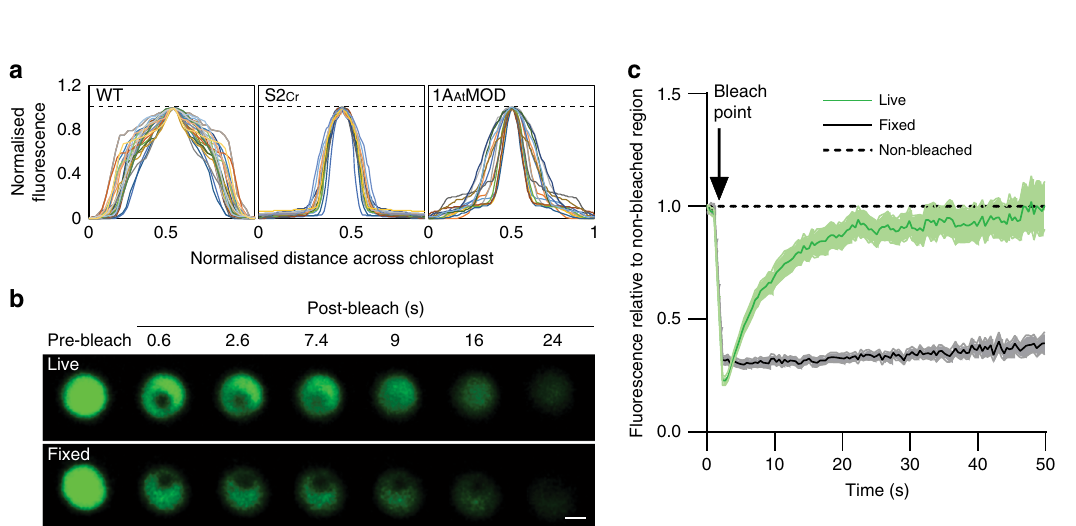
Fig. 1 Expression of EPYC1 in the Arabidopsis line S2 Cr results in condensate formation. a Schematic representation of the dual GFP expression system (EPYC1-dGFP) for EPYC1 truncated at amino acid residue 27 (as indicated by yellow triangles) and fused at the N-terminus to the chloroplastic transit peptide (TP) sequence of the Arabidopsis Rubisco small subunit RbcS1A. EPYC1 was further fused at the C-terminus to either enhanced GFP (eGFP) or turboGFP (tGFP), and driven by the 35S CaMV promoter (35S prom) or CsVMV promoter (CsVMV prom), respectively. For the latter expression cassette, a dual terminator system was used to increase expression 53 (Supplementary Fig. 1). b EPYC1 protein levels in Arabidopsis plants as assessed by immunoblot analysis with anti-EPYC1 antibodies. Shown are three T2 S2 Cr transgenic plants expressing EPYC1-dGFP (Ep1 − 3) and azygous segregants (Az1 − 3), and S2 Cr plants transformed with only EPYC1::tGFP (55.4 kDa) or EPYC1::eGFP (63.9 kDa). Also displayed are a T2 EPYC1-dGFP WT transformant (EpWT) and azygous segregant (AzWT). Anti-actin is shown as a loading control underneath. c Expression of EPYC1-dGFP in WT, S2 Cr and 1A At MOD backgrounds. Green and purple signals are GFP and chlorophyll auto fl uorescence, respectively. Overlapping signals are white. Scale bar = 10 µ m for all images. d TEM images of chloroplasts from S2 Cr plants with (right) and without (left) expression of EPYC1. A white arrowhead indicates the dense dark grey area of the EPYC1 condensate. The large white structures are starch granules. Scale bars = 0.5 µ m. A representative chloroplast from a wild-type plant expressing EPYC1-dGFP is shown for comparison in Extended Data Fig. 3. e Chlorophyll auto fl uorescence is reduced at the site of EPYC1-dGFP accumulation (white arrow). Scale bar = 5 µ m. f SIM microscopy showing EPYC1-dGFP condensates inside the chloroplast (see also Supplementary Movie 1). The magenta puncta show the position of grana stacks. Light magenta puncta indicate grana stacks behind the condensate. Scale bar = 2 µ m. g Example comparison of condensate size (left, 2 µ m) with that of a pyrenoid in Chlamydomonas (right, representative TEM image highlighting the pyrenoid in green and chloroplast in purple). Scale bar for TEM image = 0.5 µ m. Images of EPYC1-dGFP condensates in the S2 Cr background are from line Ep3 ( c , e , f , g ). Confocal images are representative of multiple imaging sessions ( c , e ). SIM microscopy ( f , g ) imaging was performed once. The immunoblots shown were derived from the same experiment and gels/blots were processed in parallel. Immunoblots results were representative of six gels/blots ( a ), TEM images are representative of 26 and 12 images from S2 Cr plants with and without EPYC1, respectively ( d ) and 55 images from Chlamydomonas ( g ). Source data are provided as a Source Data fi le.